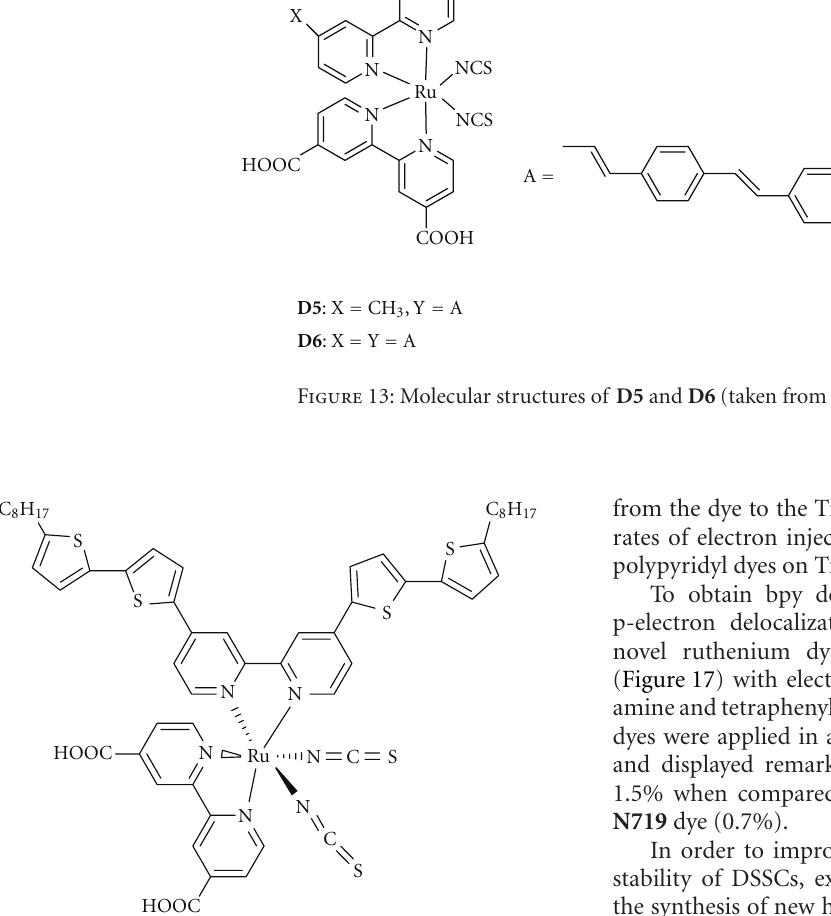
Figure 14: Molecular structure of CYC-B1 (taken from [31]).